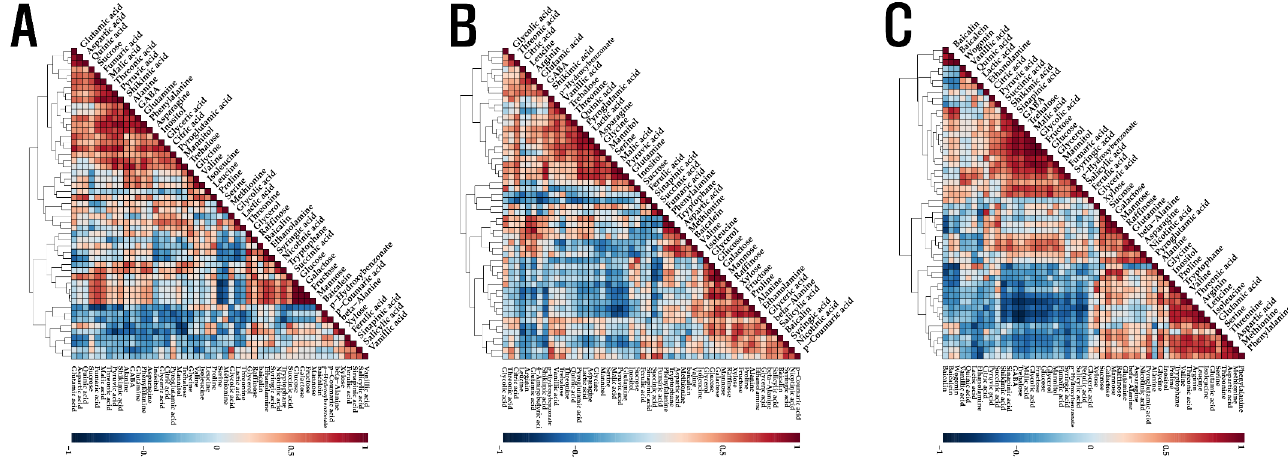
Figure 3. Correlation matrix ( A ) of metabolites obtained from the leaf of S. baicalensis seedlings grown under the LED treatment of varying duration, correlation matrix ( B ) of metabolites obtained from the stem of S . baicalensis seedlings grown under the LED treatment of varying duration, and correlation matrix ( C ) of metabolites obtained from the root of S . baicalensis seedlings grown under the LED treatment of varying duration. Each square indicates the Pearson’s correlation coefficient for a pair of compounds, and the value of the correlation coefficient is represented by the intensity of the deep blue or deep red color, as indicated on the color scale.